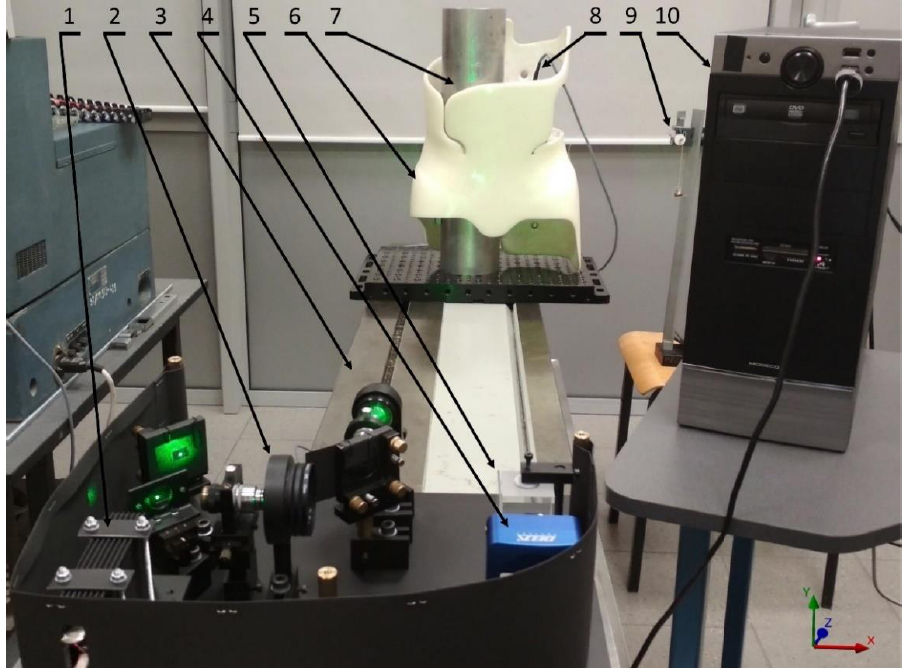
Figure 3. Brace test stand: 1—laser, 2—optical elements/optical set (beam splitter, lenses, polarisers), 3—bench, 4—digital camera (CMOS), 5—beam combiner with matte element, 6—tested object, 7—buckle for fastening and tightening of the brace, 8—pressure sensor, 9—system for application of